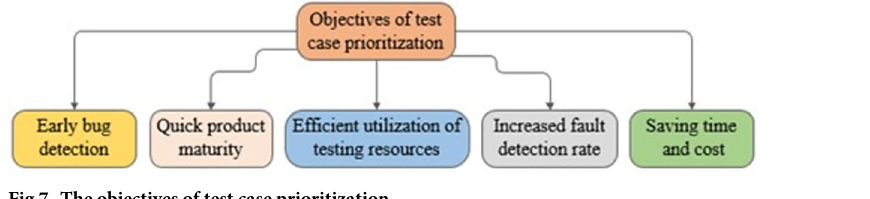
Fig 7. The objectives of test case prioritization.